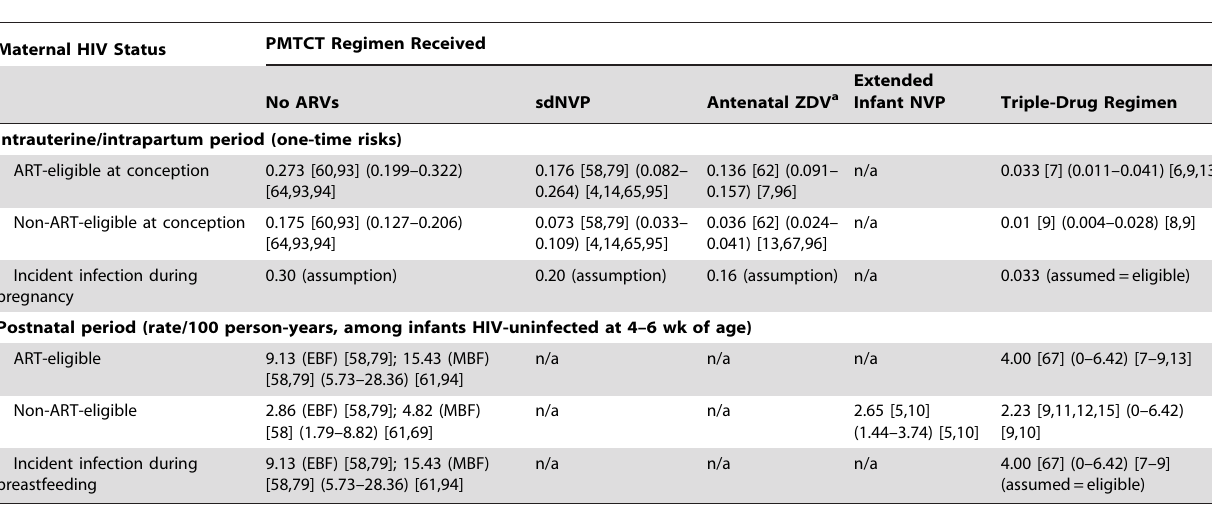
Table 3. Model input parameters: mother-to-child transmission risks.